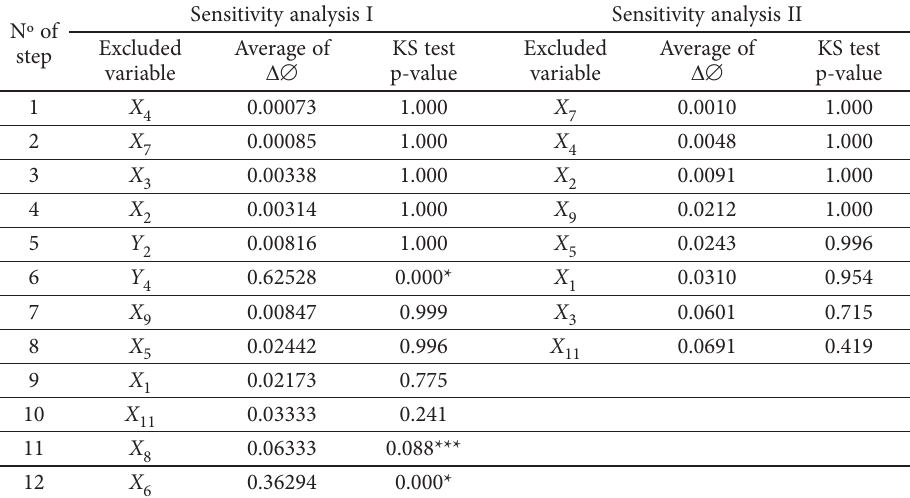
Table 6. Variable elimination sensitivity